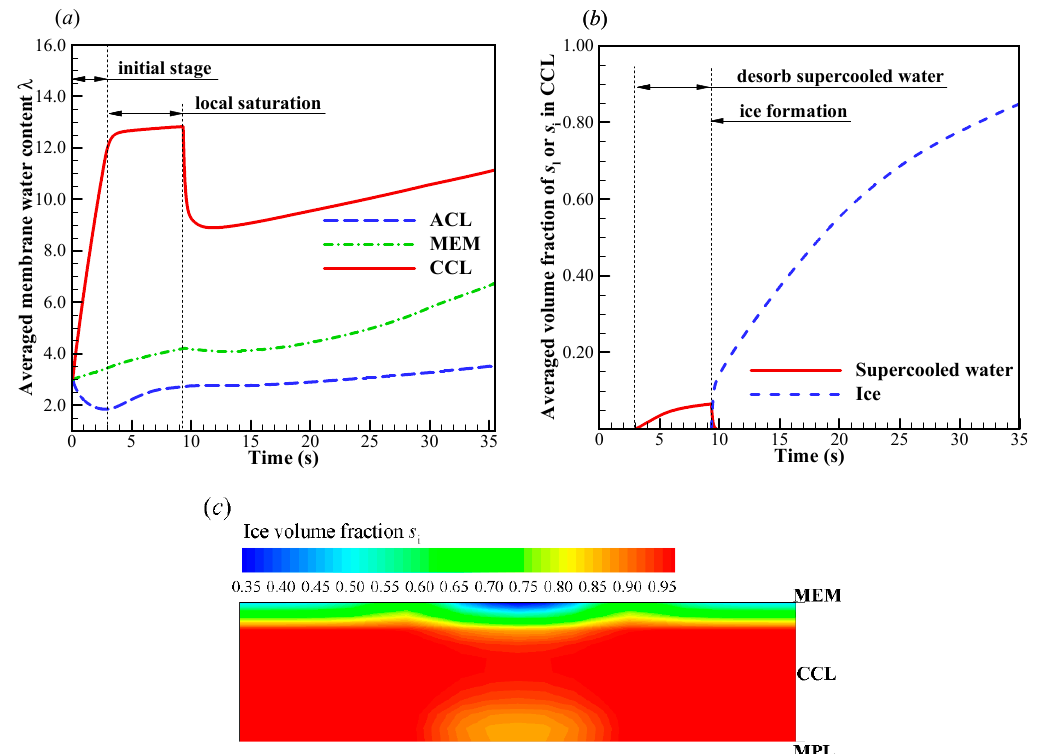
Figure 5. Evolution of ( a ) the volume-averaged membrane water content and ( b ) the averaged volume fraction of supercooled water and ice in CCL; ( c ) the contour of ice volume fraction on midway cross section (Z = 25 mm) of CCL at time t = 35.2 s. The cell starts from − 20 ◦ C and the startup current density is 0.205 A / cm 2 . The cell is supplied with dry hydrogen and oxygen. The stoichiometry ratio of the mass flow rate is 2.0 for both anode and cathode sides. The background pressure is 1.0 atm at both the anode and cathode outlets.